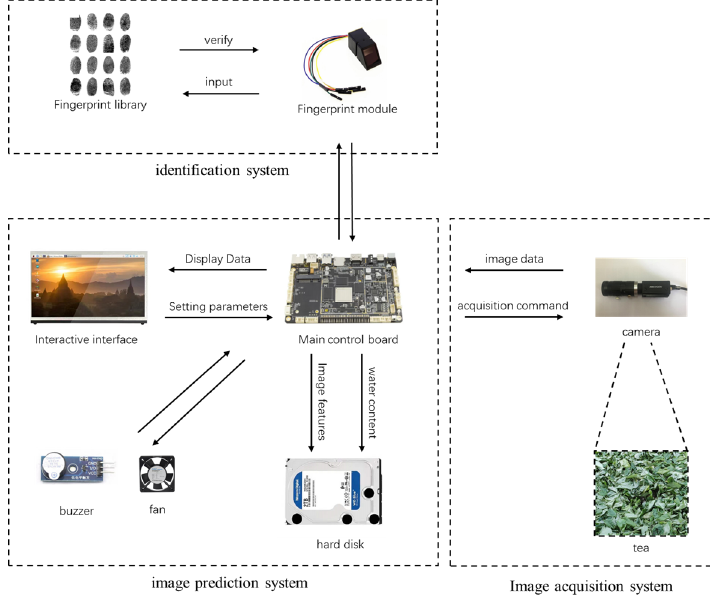
Figure 1. Composition of the Yinghong No. 9 tea leaves moisture content detection system.